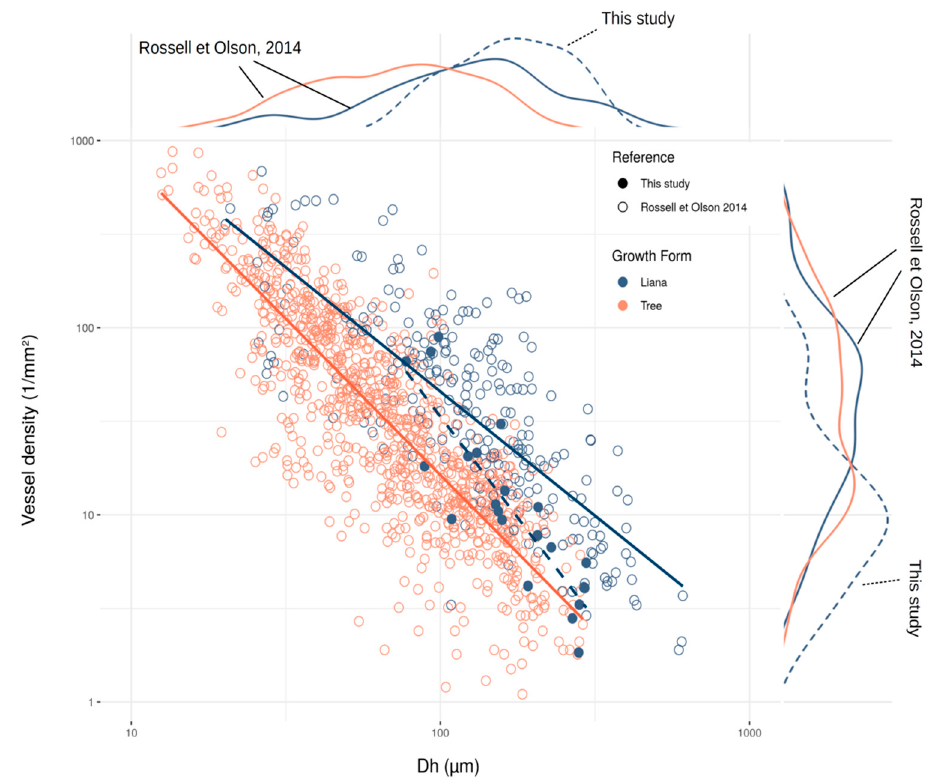
Figure 4. Relationship between the hydraulic diameter D h and the vessel density VD . The data of this study are the blue solid dots and can be compared with non-self-supporting species (blue open dots) and self-supporting species (red open dots) published by Rosell and Olson [29]. The right and top subplots compare the marginal distributions along both axes, and the dashed distributions arising from the data of this study.